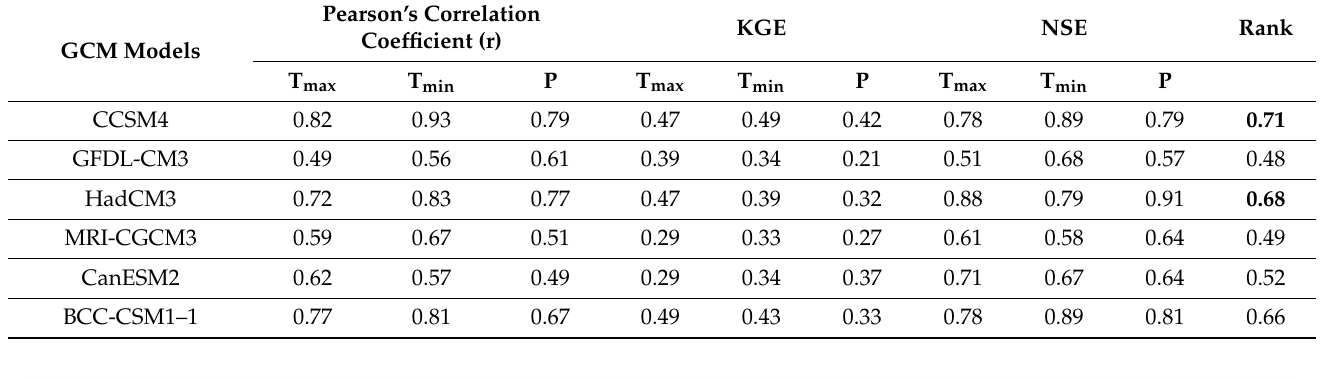
Table 7. Selection of GCMs.